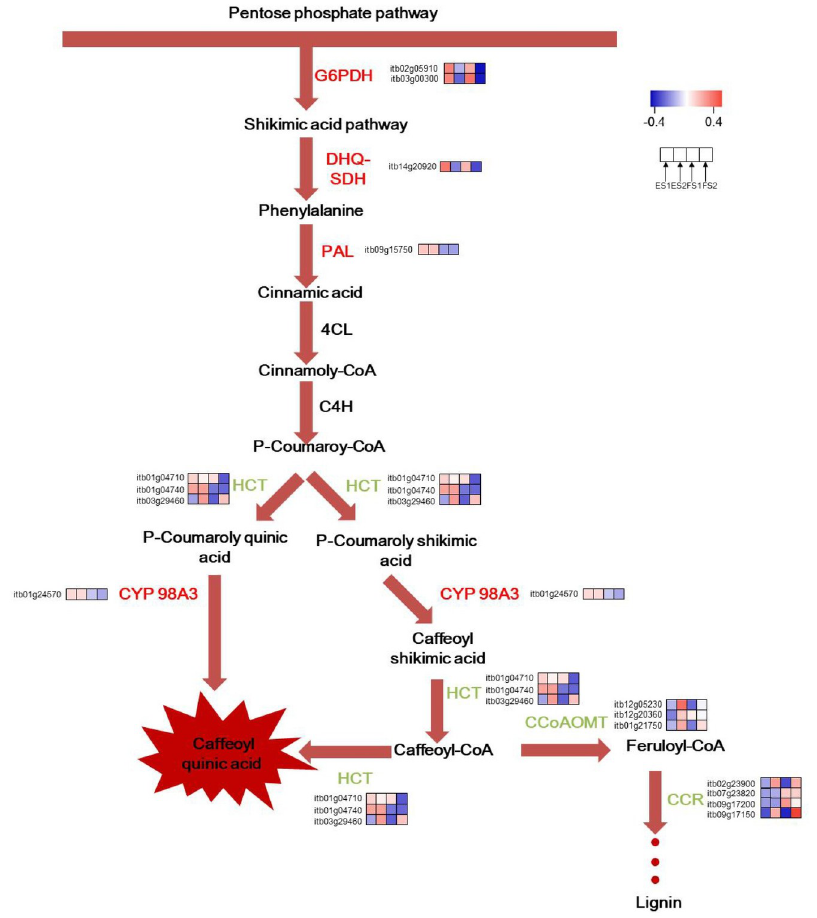
Fig 6. A hypothetical representation of the expression patterns of genes involved in the CGA biosynthetic pathway in leafy sweet potato. Upregulated Genes were shown in red, downregulated genes in green and non-DEGs in